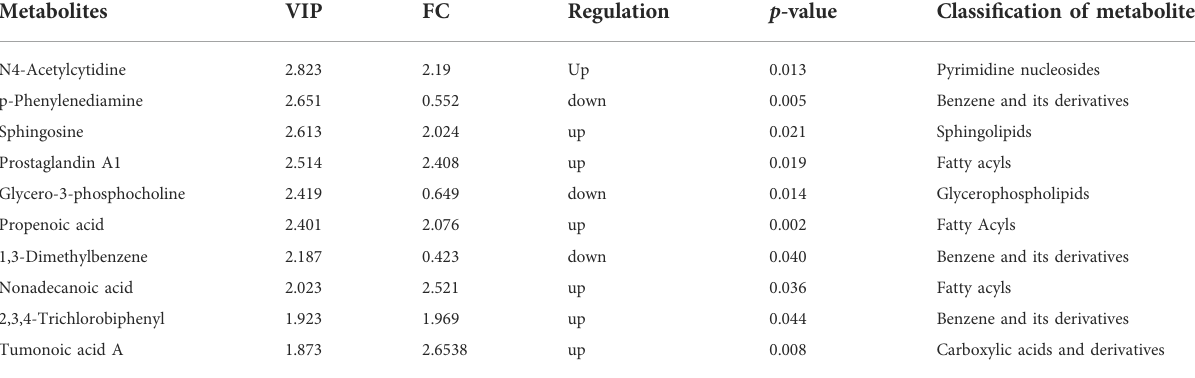
TABLE 4 Top ten distinctive metabolites between recovery and non-recovery groups. Metabolites VIP FC Regulation p